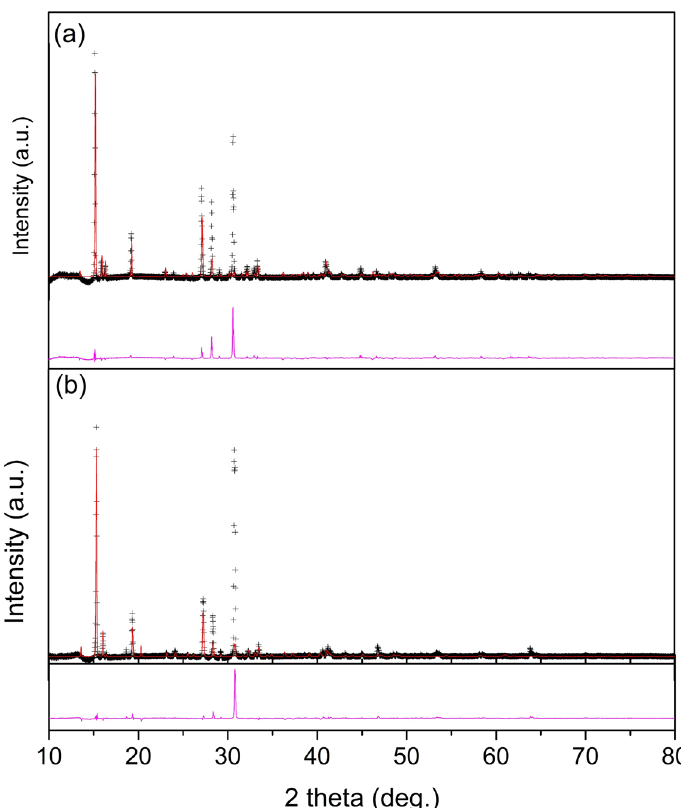
presented as the 2